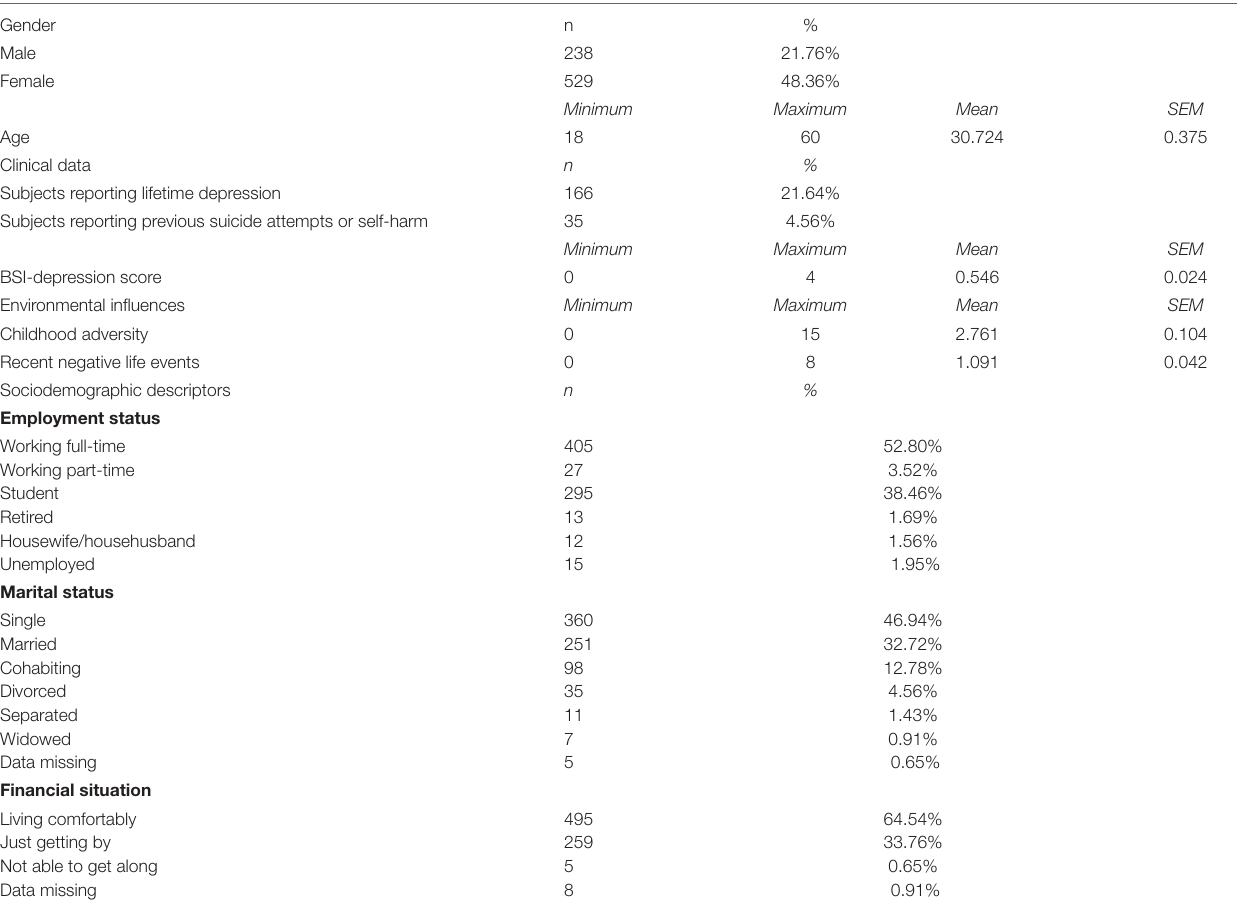
TABLE 1 | Descriptive statistics of the study sample.